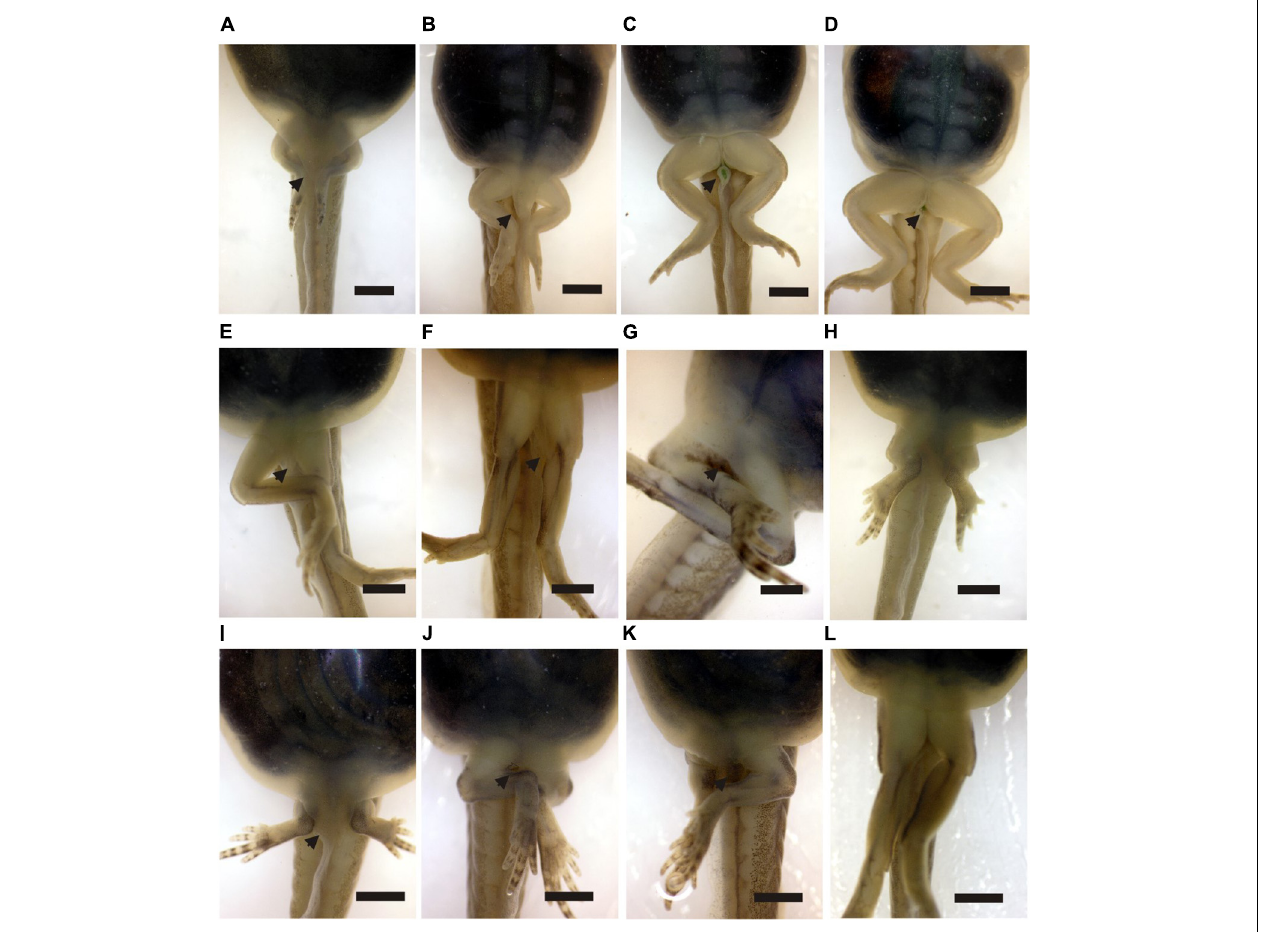
FIGURE 7 | (A–D) Sequence of disappearance of vent tube in Pleurodema borellii in normal development observed in Gosner Stages 37, 39, 40, and 41. (E–H) Different morphologies of vent tube and asymmetry of legs in specimens exposed to methimazole. (I–L) Different morphologies of vent tube and asymmetry of legs in specimens exposed to T4. Scale bar is equal 2